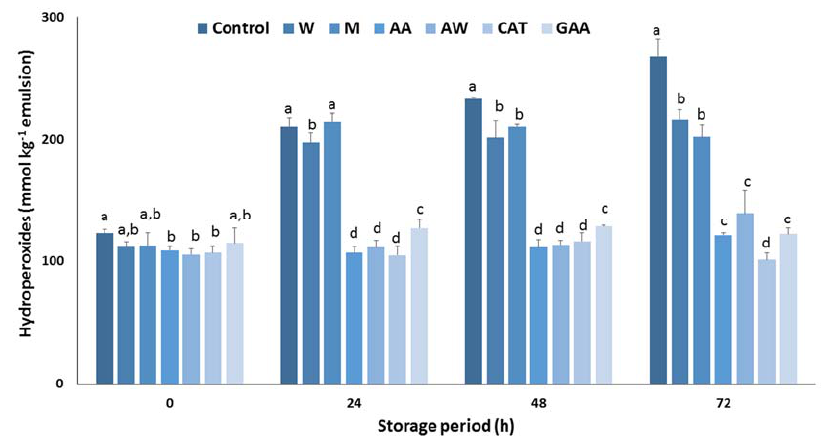
Figure 2. Antioxidant activity of carob extracts, gallic acid, and catechin in sunflower oil in water emulsion for 72 h at 60 °C. The symbols W, M, AW, AA represent the water, methanol, acetone–water, and acidic acetone extracts; GA and CAT denote gallic acid and catechin, respectively. Means ± standard error labelled with the same letter did not differ significantly ( p ≤ 0.05) according to Duncan’s test.